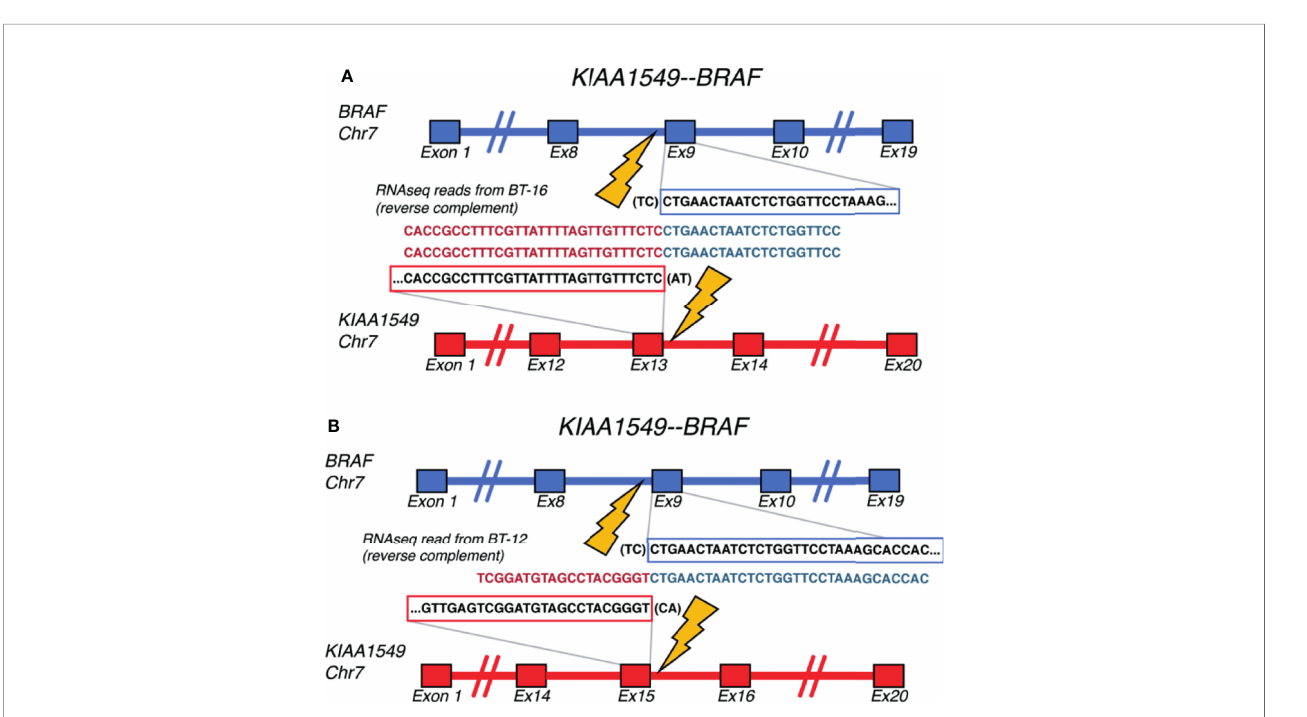
FIGURE 10 | Schematic representation of the KIAA1549-BRAF fusion transcripts identi fi ed for (A) BT-16 and (B) BT-12 samples of spinal intramedullary astrocytoma